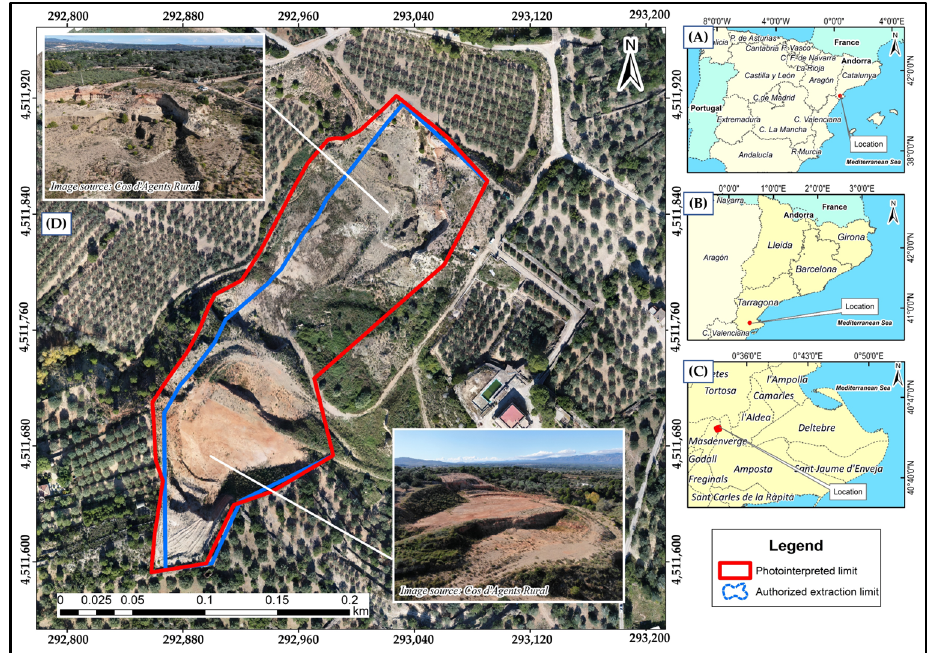
Figure 1. ( A ) Location of the study area at the autonomous precinct level. ( B ) Location at the province level. ( C ) Location at the municipality level. ( D ) Orthophoto view of the Belen waste dump.